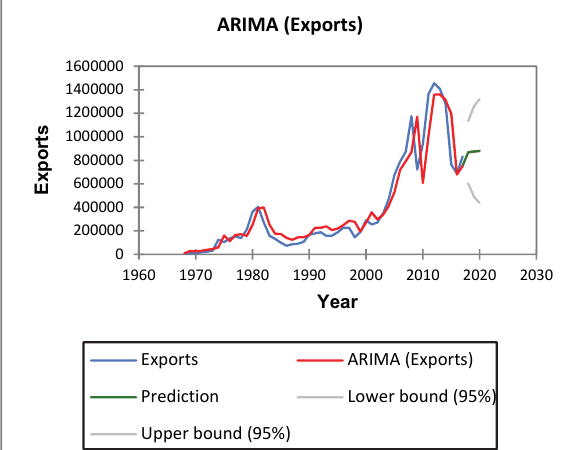
Fig. 4. The results of Export using Neural Network Fig. 5 . The results of of Export using ARIMA (1, 1, 2)